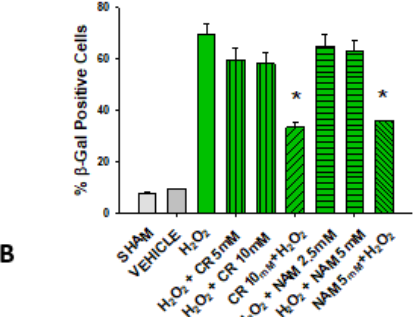
Figure 6. Effect of Cr and NAM post treatment on oxidant induced β -gal activity. DHF were treated with vehicle for 24 h, followed by exposure to 600 µM H 2 O 2 for 2 h, followed by treatment with Cr or NAM. 72 h later cells were harvested for β -gal staining. In some experiments, DHF were pre- treated with 10 mM Cr (Cr 5 mM + H 2 O 2 ) or 5 mM NAM (NAM 5 mM + H 2 O 2 ) before oxidant expo- sure as in Figure 2. ( A ) Representative pictures of β -gal staining in response to various treatments. ( B ) % β − gal positive cells in response to various treatments. The data are mean ± SE from 3–4 sepa- rate experiments using duplicate samples. * Denotes statistically significant changes in the Cr/NAM pretreated levels in comparison to H 2 O 2 alone. None of the post-treatments were statistically significant in comparison to the H 2 O 2 treatment alone.